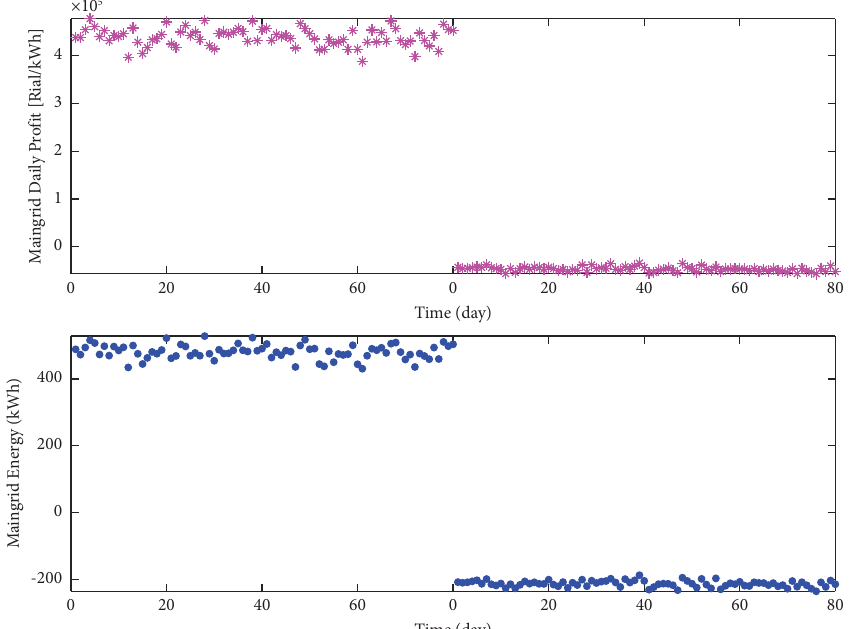
Figure 12: Average daily proft of the main grid and the average daily power received from main